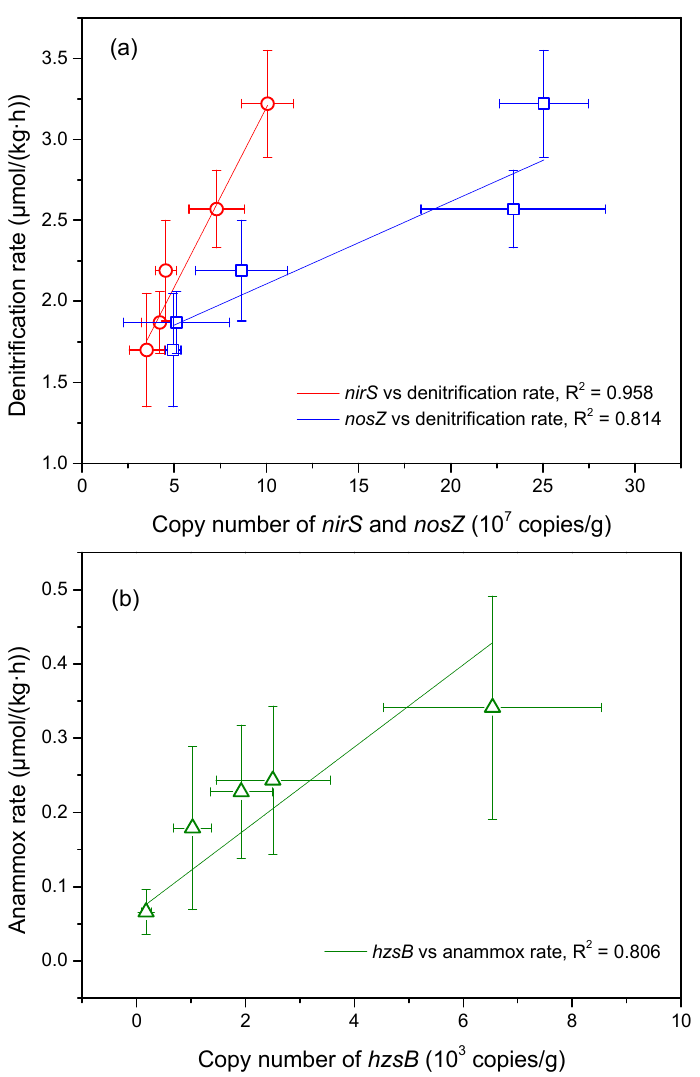
Figure 6. Relationships between ( a ) denitrification rate and copy numbers of denitrification genes ( nir S and nos Z) ( b ) anammox rate and copy number of hzs B ( b ).